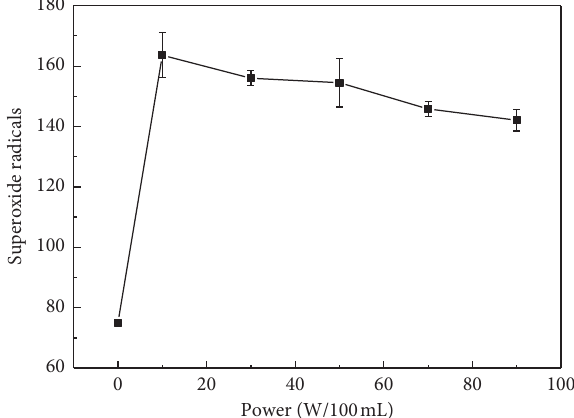
Figure 6: The effect of ultrasonic power on superoxide radicals. Table 2: Changes in the free amino acids in the vinegar during the ageing